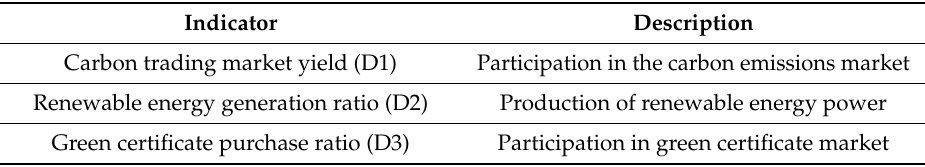
Table 4. Green market trading